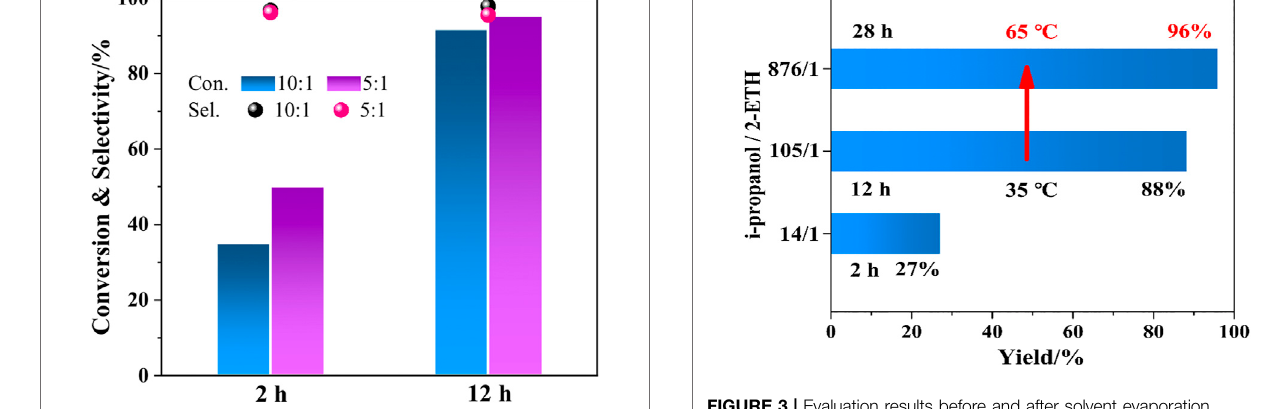
FIGURE 2 | Evaluation results of adjusting the mass ratio of 2-ETH.